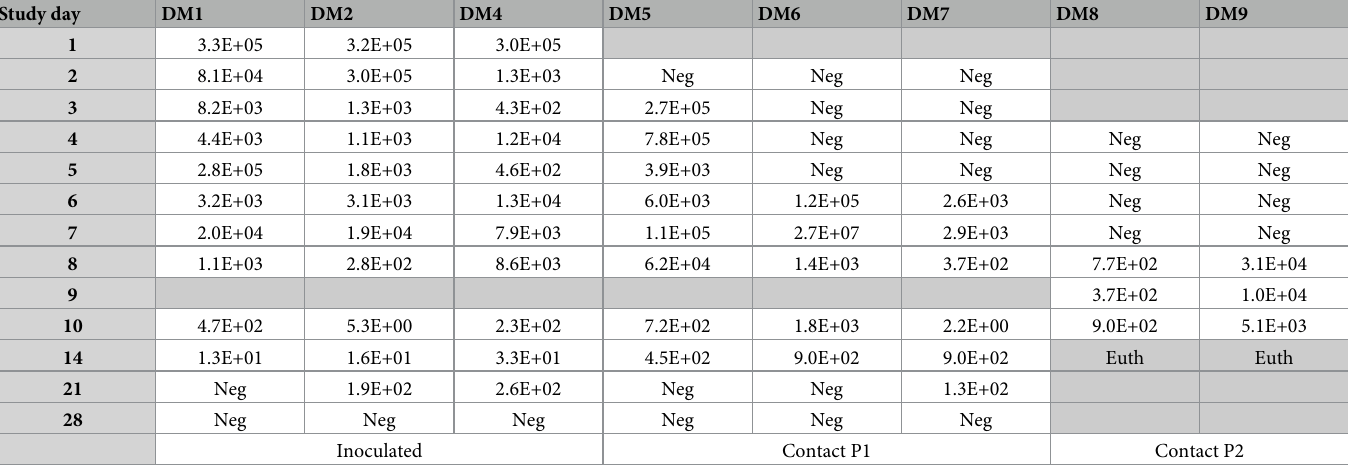
epithelial cells and scattered alveolar lining cells. Some inflammatory foci were interspersed by multinucleate syncytial cells. Perivascular mild neutrophilic infiltrates were present around main blood vessels at the base of the heart and around renal hilar vessels and nerves at 6 dpi (S10 Fig). Other visceral organs did not show significant pathologies. Occasional multinucleate cells of epi- thelial and histiocytic origin were scattered amongst inflammatory infiltrates. Inflammation sig- nificantly subsided at 14 dpi where lungs showed mild pulmonary fibrosis and residual pneumonia. Hemorrhage was less prominent to absent in lungs of infected deer mice by 14 days. Lamina proprial cellularity of the small intestine, particularly duodenum and ileum, moderately increased by 6 dpi and immunoreactivity was detected in crypt epithelium and mature entero- cytes along with occasional submucosal macrophages (S9 Fig). SARS-CoV-2 transmission To assess transmission, 3 deer mice were intranasally inoculated with 2x10 4 TCID and the next day they were moved to a new cage containing 3 naive contact deer mice. Oral swabs, but not rectal swabs, of the three contact deer mice (DM5, DM6, DM7) became vRNA + on days 2, 5 and 5 post-contact (P1, days 3 and 6 of the study, Table 1). As they became Table 1. Detection of vRNA in oral swabs.